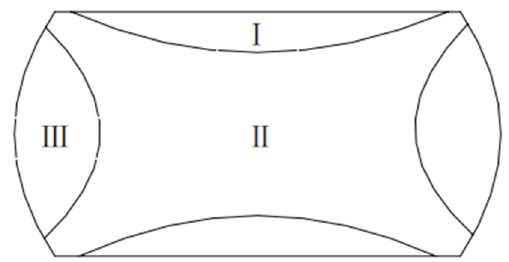
Figure 13. Schematic of the non-uniformity of compressed sample.